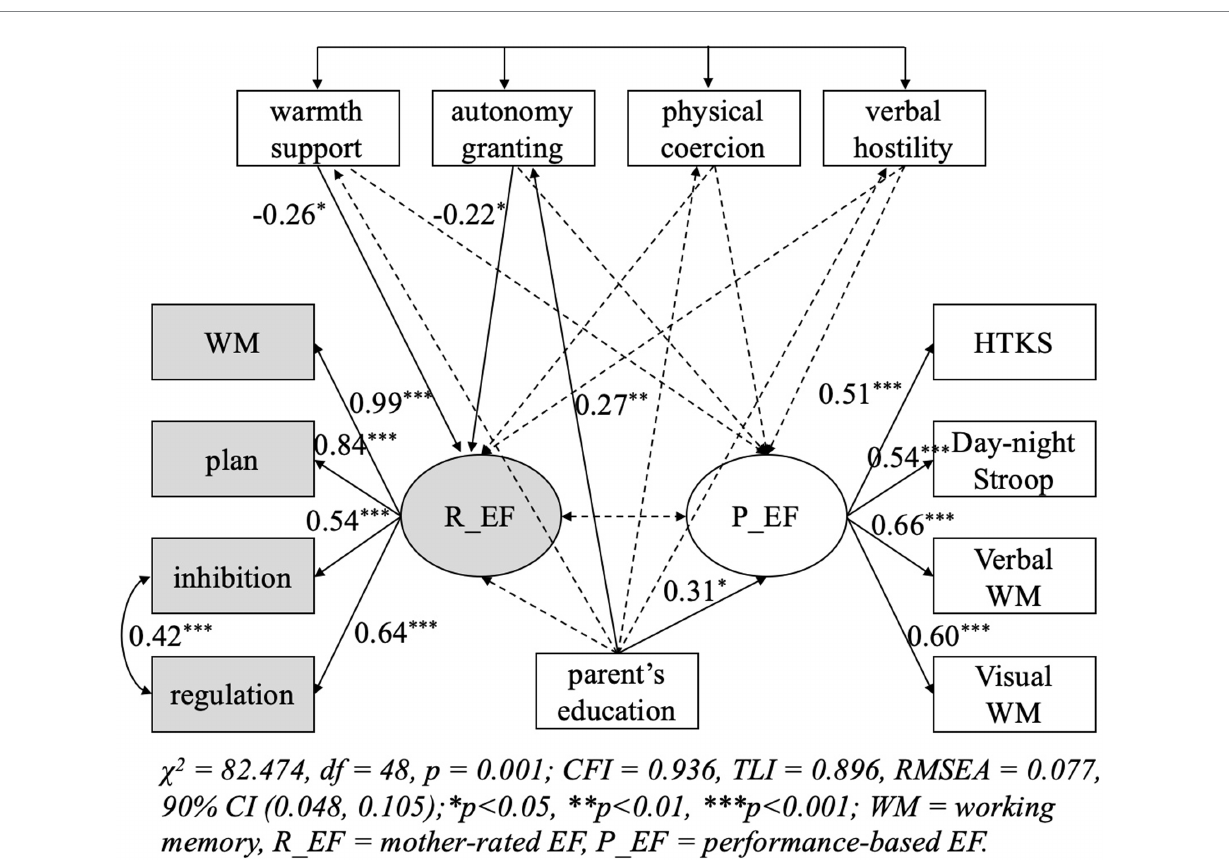
FIGURE 2 Predicting children’s executive functions from mother-reported